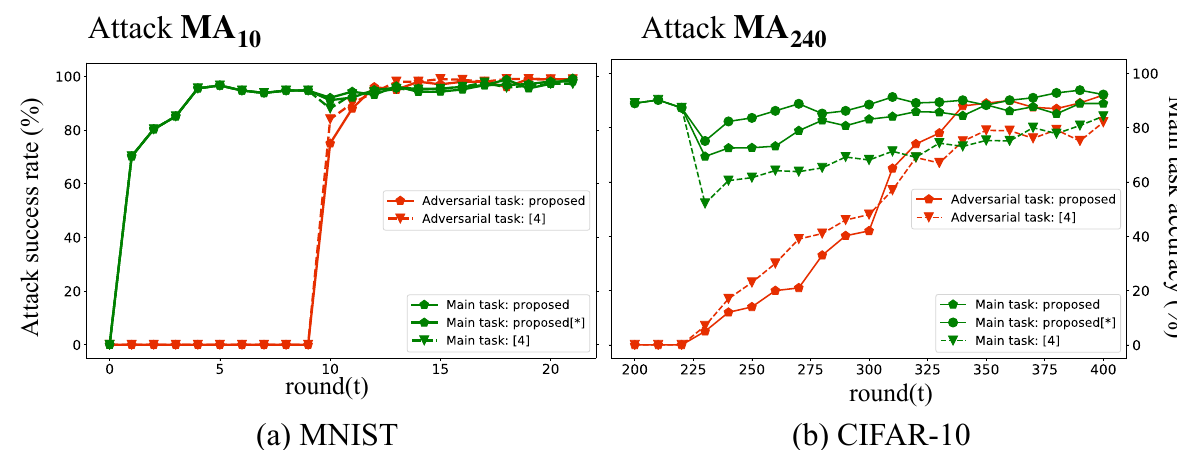
Figure 4. Comparison of the accuracy (green) and attack success rate (red) for shared global model between proposed deep model poisoning and backdoor attack in [4] under a multiple-shot attack scenario. “Proposed[*]” denotes the proposed attack without a constrained regularization term in adversarial task (i.e., ρ 2 = 0 in Equation (3)).